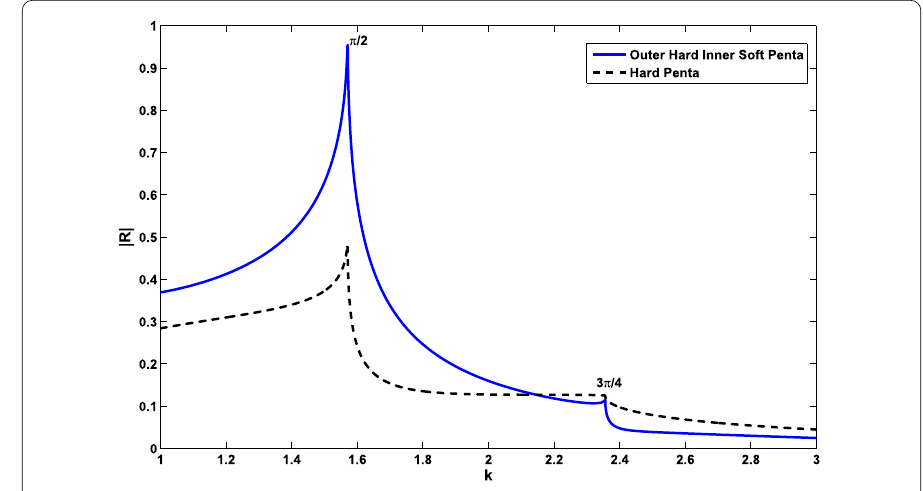
Figure 7 Reflected field amplitude | R | versus the wave number k for two pentafurcated problems for a = 1, b = 2 and d = 4.